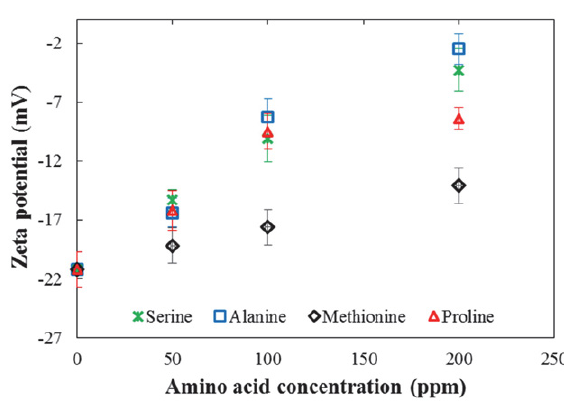
Figure 6. Variation of zeta potential with amino acid concentra- tion.